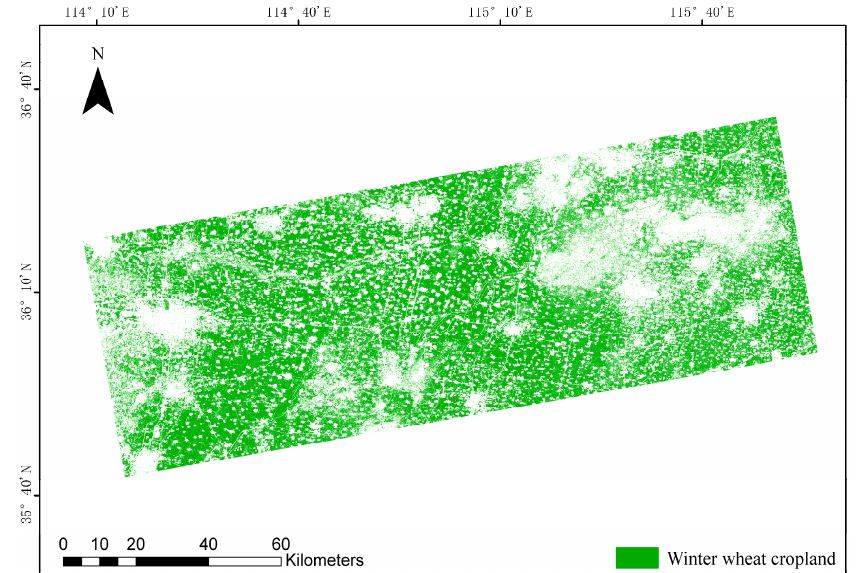
Figure 5. Extraction of winter wheat cropland in the test region by the multi-temporal stacked Sentinel-1A bands using a parallelepiped classifier. The total accuracy of the classification was 84% and the Kappa coefficient was 0.77.